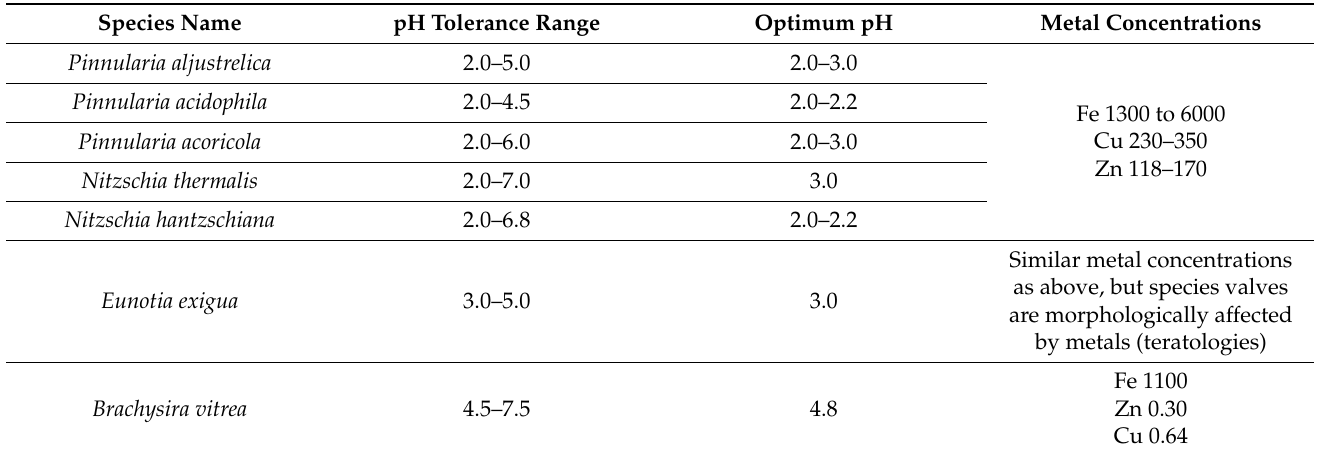
Table 1. Diatom species with pH and metal concentrations (mg/L), pH tolerance range and opti- mum